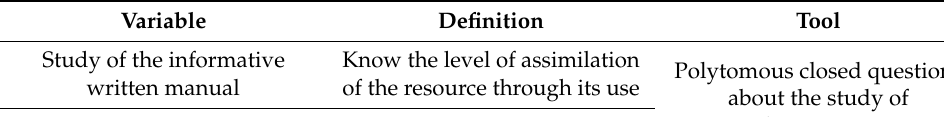
Table 2. Description of independent